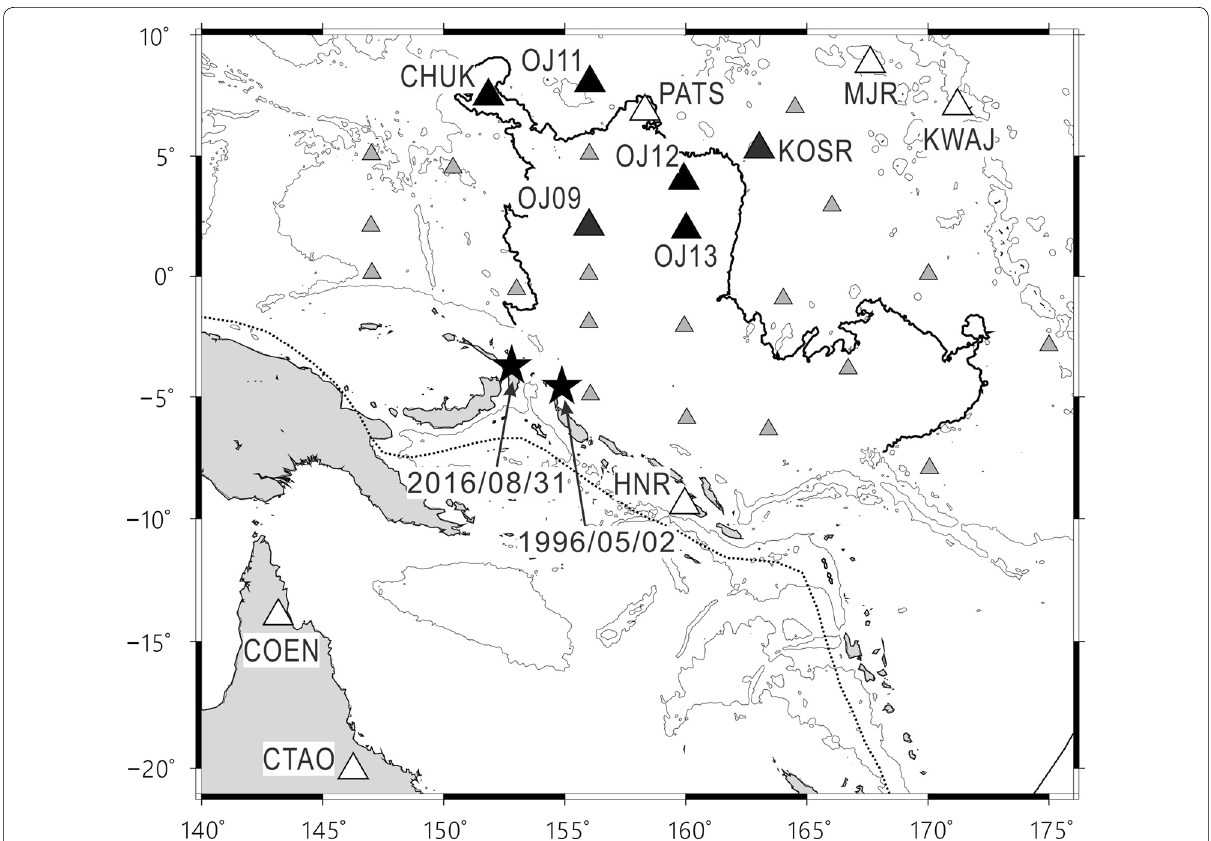
Fig. 1 Map showing seismological stations of the OJP array and permanent stations around the OJP. The black and small gray triangles denote the stations of the OJP array, and the open triangles denote permanent stations. Seismograms at the locations of the black and open triangles were analyzed in the present study. The small gray triangles denote stations with low signal-to-noise ratios of multiple ScS waves or stations that were terminated at the time of the event on Aug. 31,